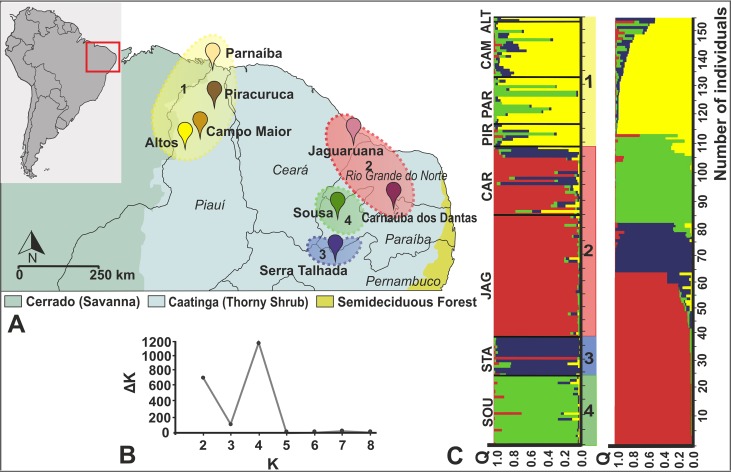
A—Sampling sites map of R. nasutus specimens; B– ΔK values are shown for K ranging between 2 and 8; C—population structure of R. nasutus estimated with Structure for K = 4 organized by geographic region (on the left) and by Q value (on the right). Each vertical bar represents the individual probability of a single bug to belong to a specific genetic cluster; the color(s) in each bar represent the proportion of the individual’s genome coming from each of the four assumed clusters. Black lines separate the sampling localities. Structure diagrams for K = 2–8 are presented as supporting information (S1 Fig).